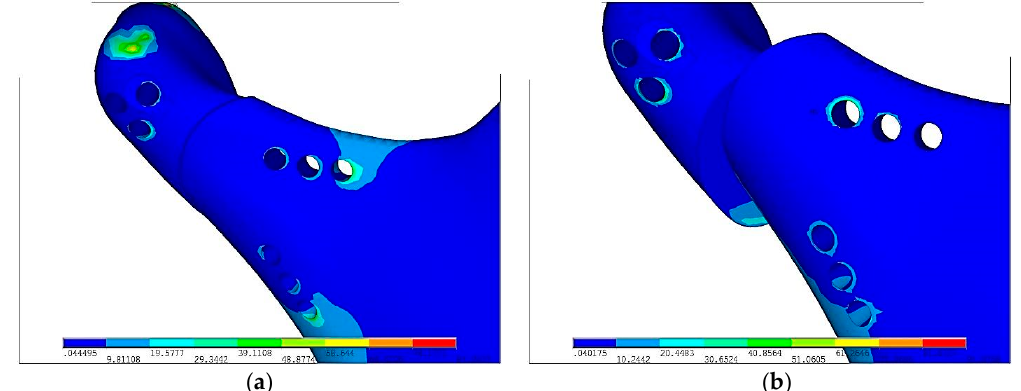
( b ) Figure 8. Equivalent stress distribution on plates according to von Mises hypothesis following plate